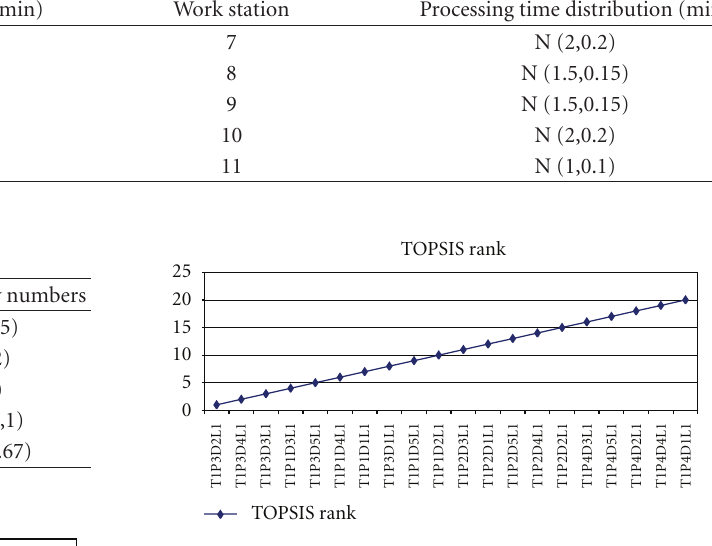
Figure 6: Strategies ranking by TOPSIS method.